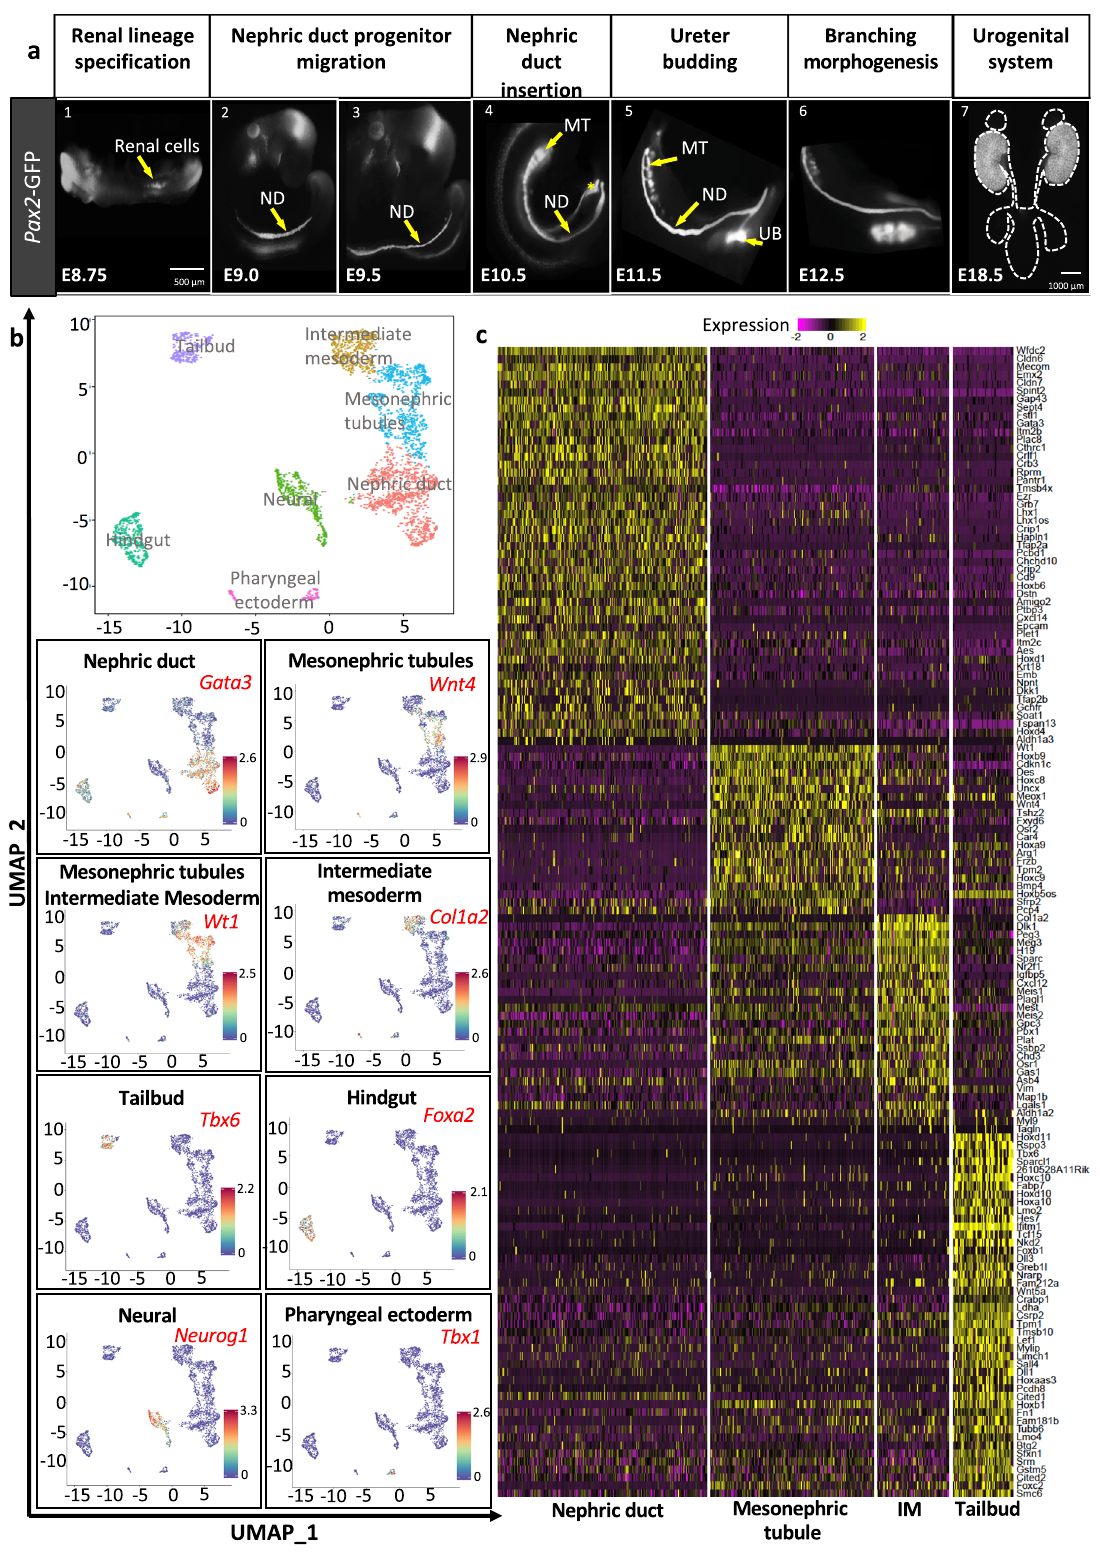
that emerges in the ND, detected at the protein level from E9.5 on (Fig. 2e NdPr4 panel). Importantly, NdPr4 is a caudal population restricted to the Intermediate II and Tip regions of the developing ND (Fig. 2e NdPr4